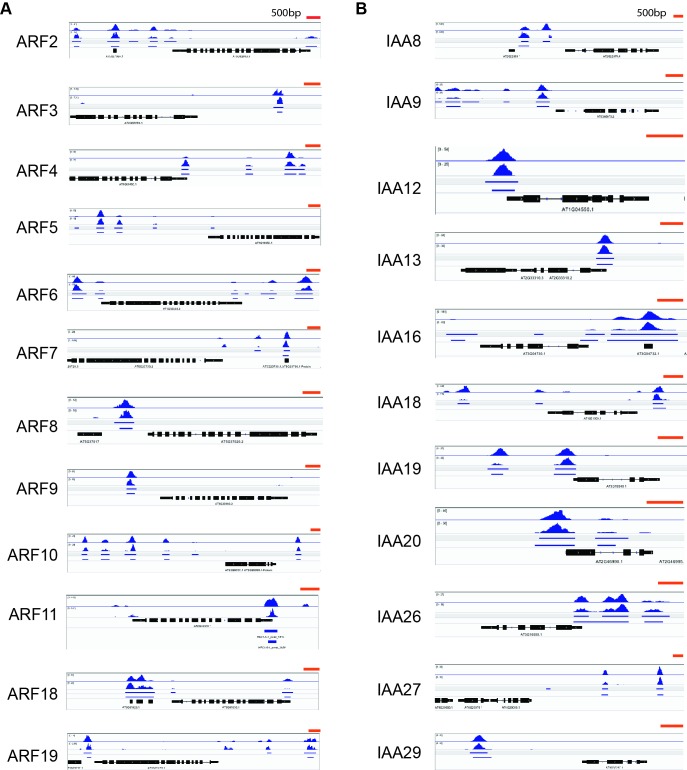
Visualization of HEC1 binding peaks at the loci of ARFs and Aux-IAAs expressed in the SAM.(A) IGV visualization of HEC1 binding peaks at the promoter of ARFs expressed in the SAM. (B) IGV visualization of HEC1 peaks at the promoter of Aux-IAAs expressed in the SAM (Vernoux et al., 2011). Biological duplicates are depicted.